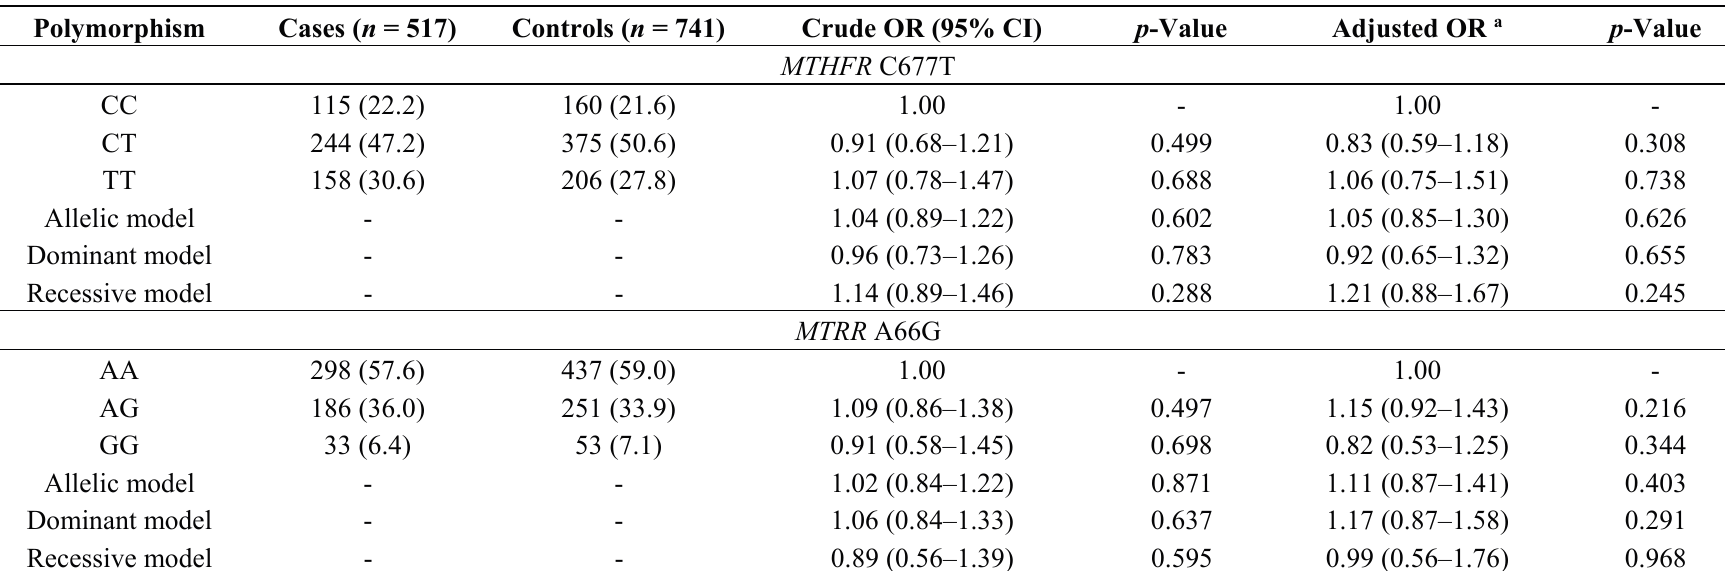
Table 2. Association of the MTHFR C677T and MTRR A66G polymorphisms with overweight/obesity